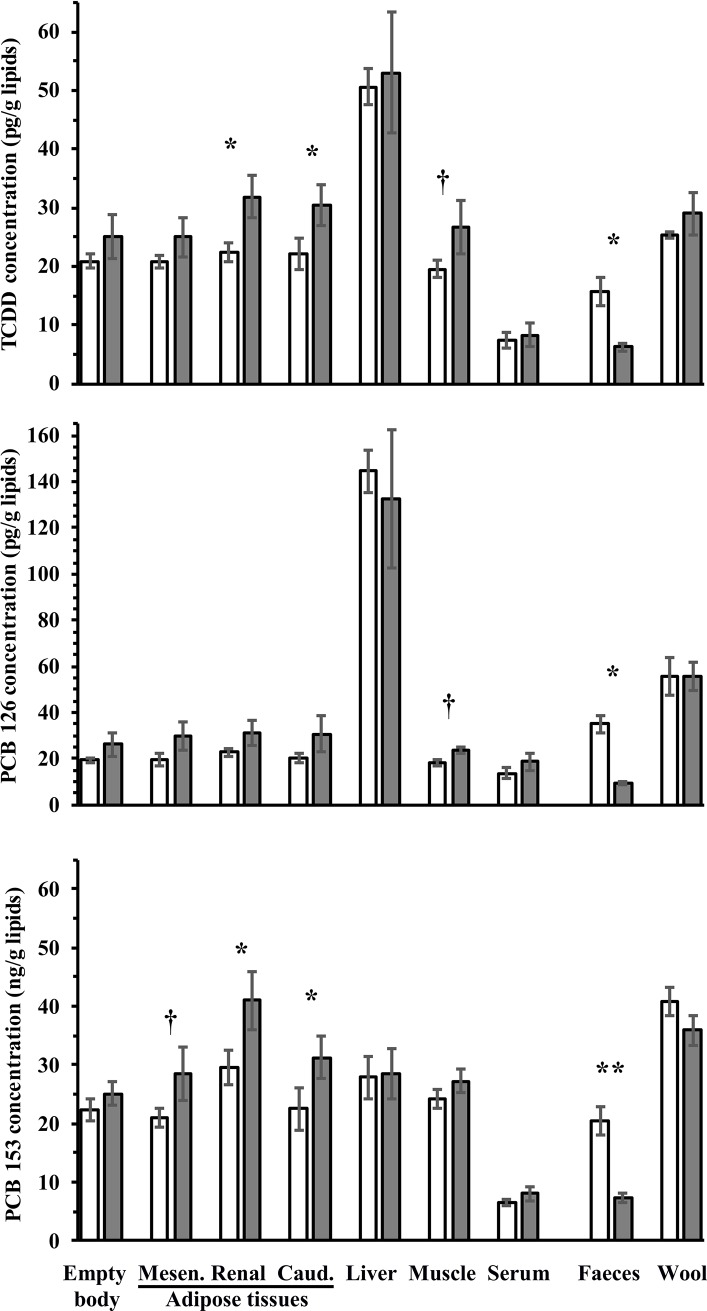
Pollutant concentrations in body tissues of ewes at slaughter and in excretion compartments over the depuration period in ewes receiving a control well-fed and non-supplemented treatment (CTL, open bars; n = 4), or an underfed and mineral oil supplemented treatment (UFMO, grey bars; n = 5).Bars represent least-squares means, error bars represent SEM, * and ** represent a difference (P ≤ 0.05 and 0.01, respectively) and † represents a tendency for difference (P ≤ 0.10) between treatments. Mesen.: mesenteric; Caud.: pericaudal subcutaneous.